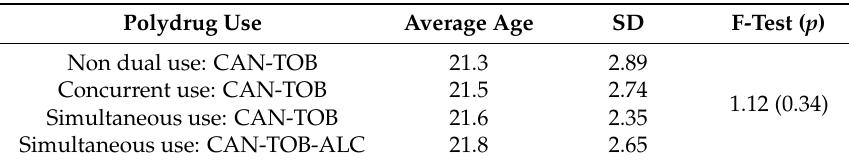
Table 2. Patterns of polydrug use by age.